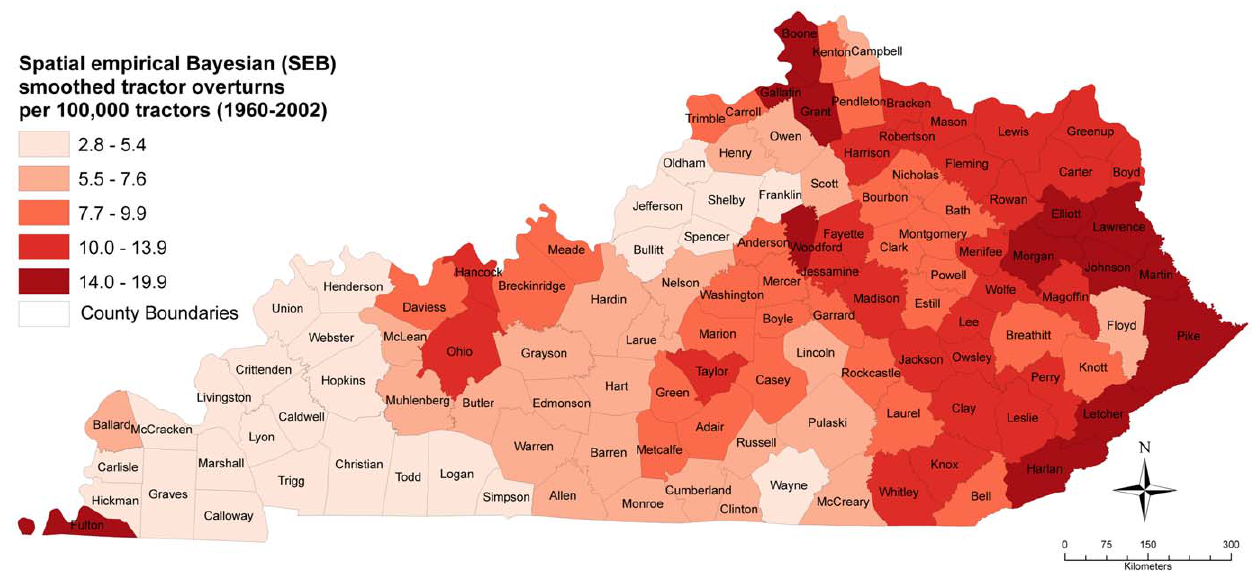
Figure 2. Spatial Empirical Bayes’ (SEB) smoothed tractor overturn rates in Kentucky, 1960–2002.